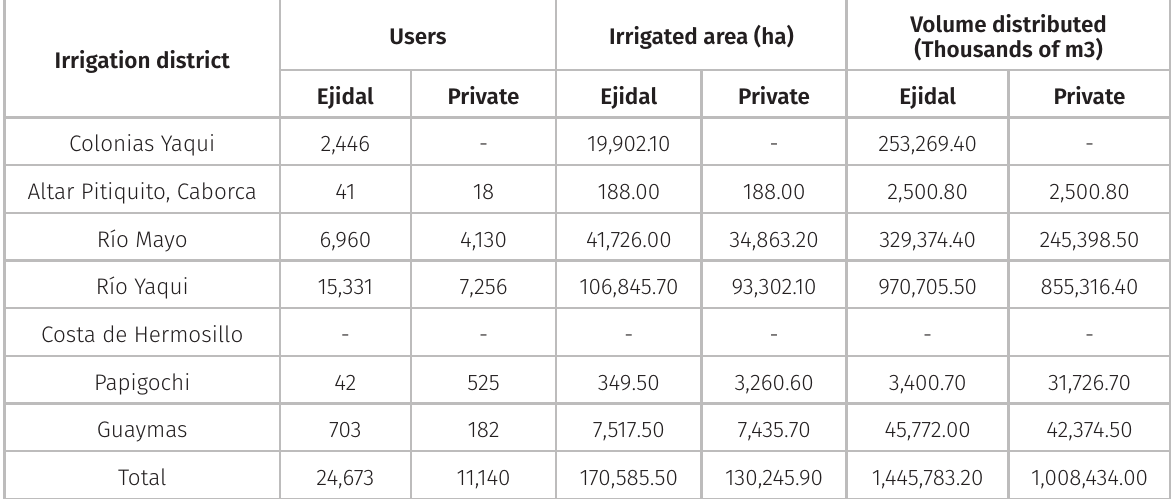
Table II. Physical irrigated surfaces and volumes distributed by type of use and tenure in the irrigation districts of the Northwest basin organisation